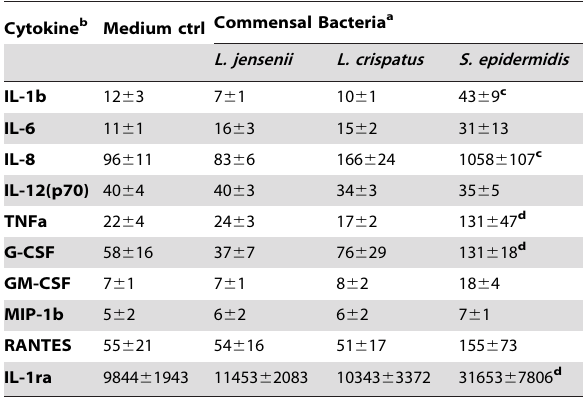
Table 2. VEC multilayer cultures selectively responded to non-vaginal commensal